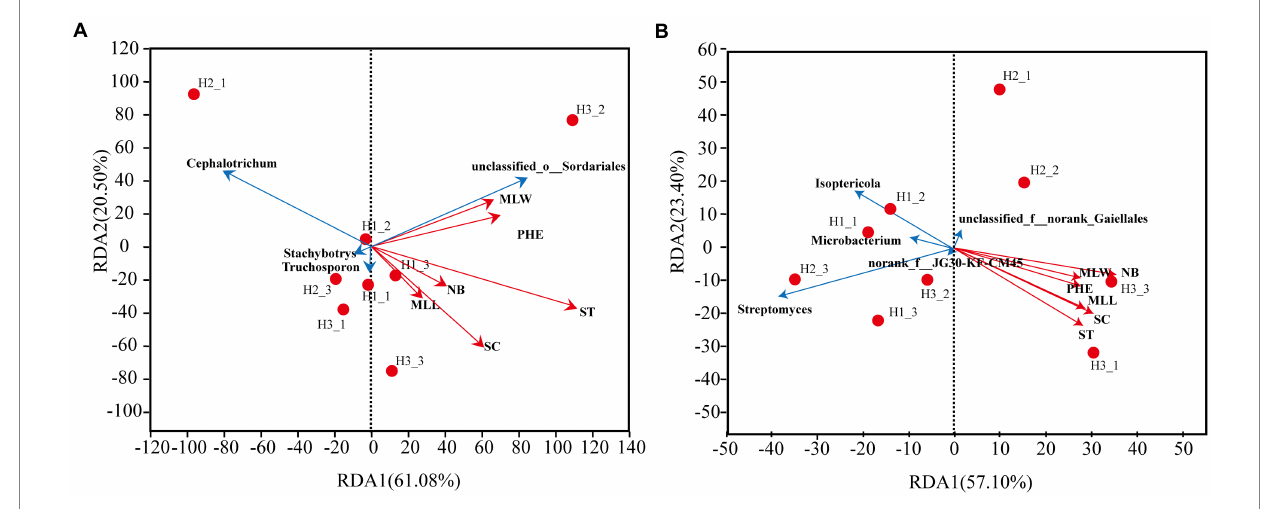
FIGURE 10 RDA analysis between dominant rhizosphere genera and growth indicators. (A) Fungal community. (B) Bacterial community. MLL, maximum leaf length; MLW, maximum leaf width; NB, number of leaves; PHE, plant height; ST, stem thickness; SC, stem